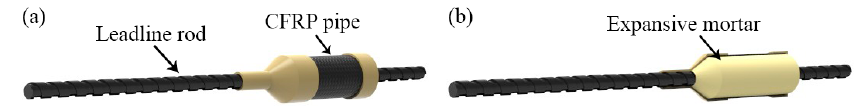
Figure 7. Anchorage system used in Tsukuba FRP Bridge, ( a ) full view and ( b ) transparent view.